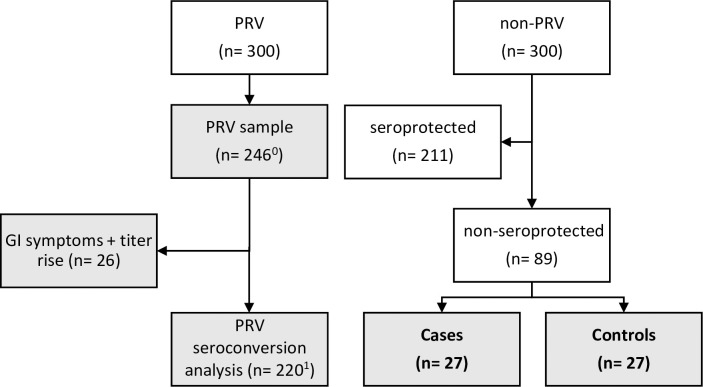
Study design flow chart: Grey shading denotes specimens tested with MEEDAT and ELISAs, and inclusion in tests of biomarker associations with growth and parenteral vaccine seroconversion (YFV, MenAV). Bold text denotes inclusion in Case-Control study.Abbreviations: GI, gastrointestinal; PRV, pentavalent rotavirus vaccine. 0 includes n = 152 tested with the GLP-2 ELISA. 1 includes n = 133 tested with the GLP-2 ELISA who did not experience GI symptoms and IgG or IgA titer rise.